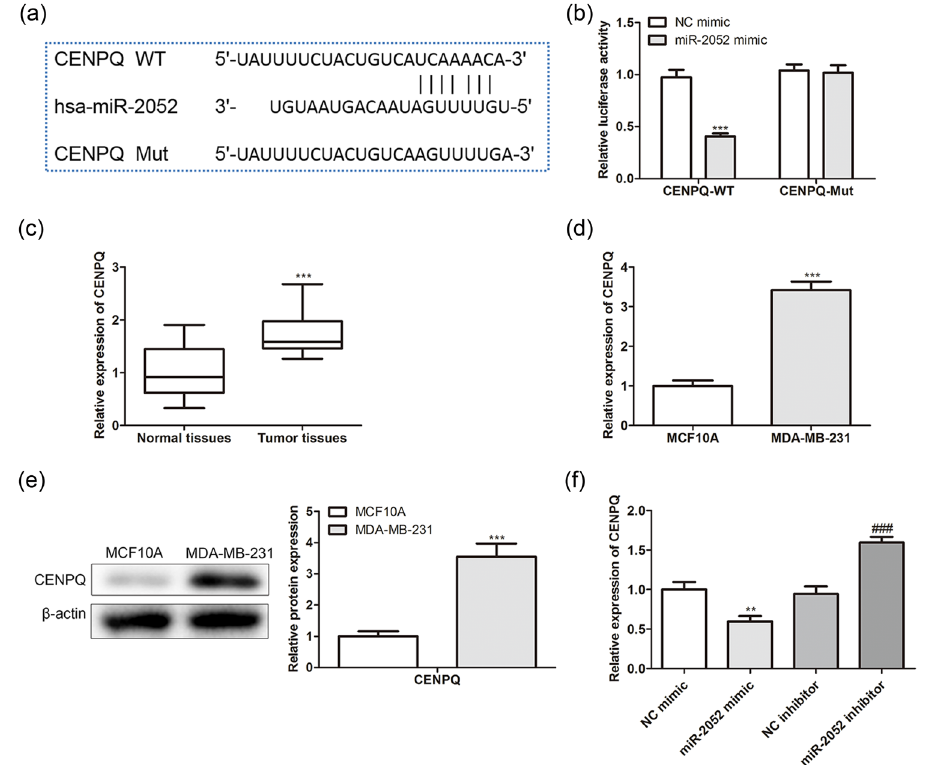
Figure 4: MiR - 2052 targets CENPQ in BC: ( a ) the binding sites between miR - 2052 and CENPQ; ( b ) the interaction between miR - 2052 and CENPQ was evaluated by a dual - luciferase reporter assay. *** P < 0.001 vs NC mimic group. ( c ) CENPQ levels in BC tissues were detected by the qRT - PCR assay. *** P < 0.001 vs normal tissues. CENPQ levels in BC cells were detected by ( d ) qRT - PCR and ( e ) western blot assays. *** P < 0.001 vs MCF10A cells. ( f ) CENPQ levels in BC cells transfected with miR - 2052 mimic/inhibitor were determined by qRT - PCR assay. ** P < 0.01 vs NC mimic group and ### P < 0.001 vs or NC inhibitor